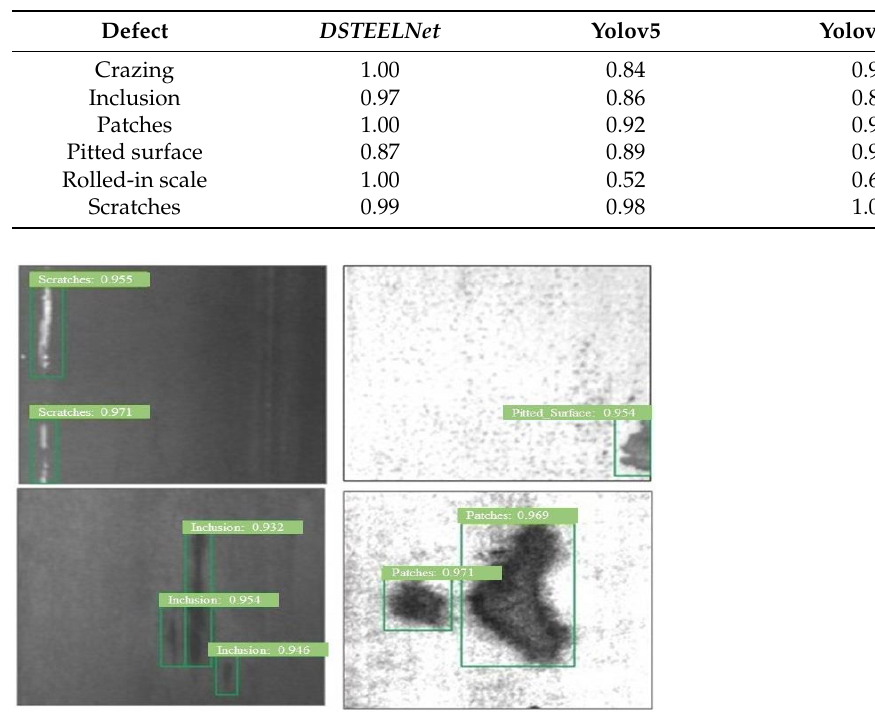
Figure 9. Training and validation accuracy of DSTEELNet on GNEU.